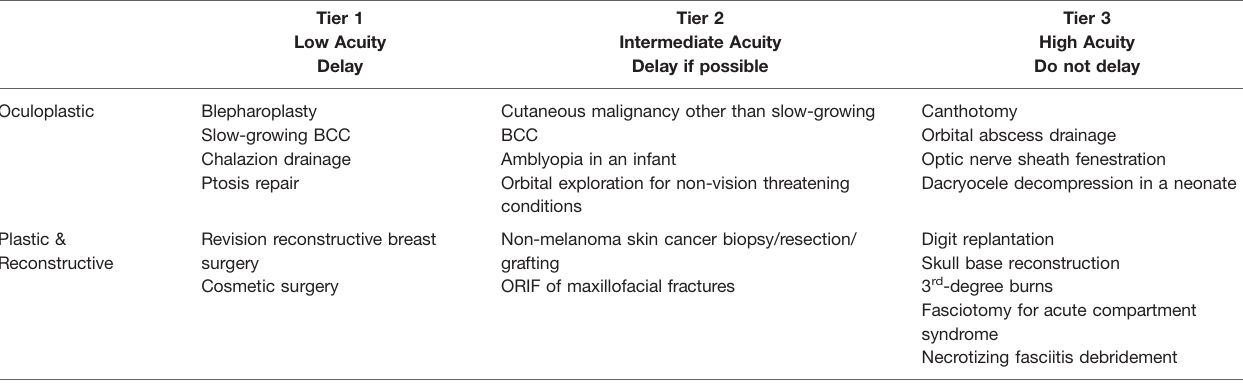
TABLE 7 | Plastic, Oculoplastic, and Reconstructive Elective Surgery Acuity Scale (ESAS). All candidates for surgery should be assessed for surgical fi tness on an individual basis. This is an example ESAS and not comprehensive. Procedure acuity for the individual patient may shift among tiers based upon acuity of illness, severity of COVID-19 infection and coagulopathy, and hospital surgical capacity (199 – 201). For speci fi c length of operative delay, please see the text and Association of Anesthesiologists guidelines